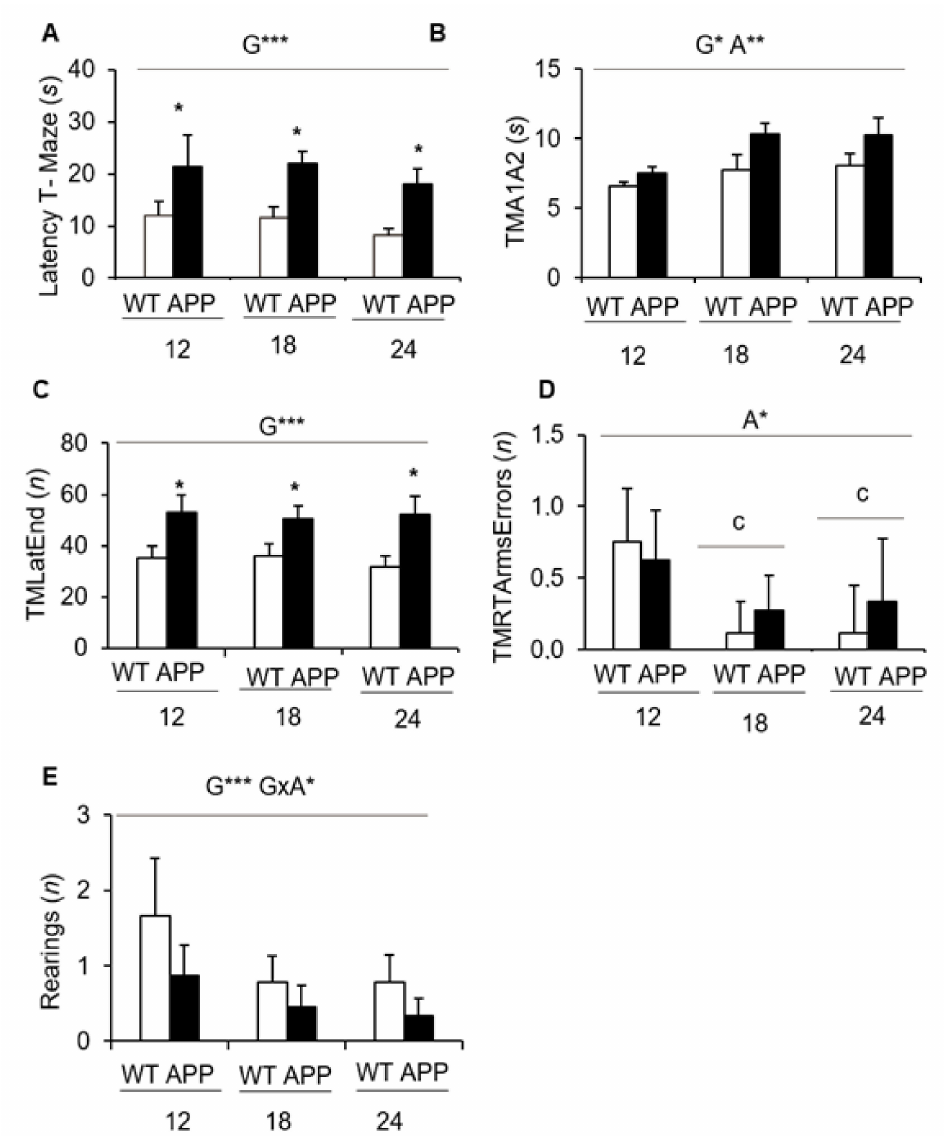
Figure 4. Coping with stress strategies, risk assessment, and spontaneous alternation in the T-Maze. ( A ) Latency to cross the intersection; ( B ) Total time invested in the exploration of the left and right arms; ( C ), Time to complete the exploration of the maze; ( D ), Total number of errors performed during the exploration of the maze; ( E ) Vertical exploratory activity. Data are expressed by means ± SEM. WT: wildtype mice; APP: APP23 mice. Analysis of variance 2 × 2: Effects of genotype (G), age (A), genotype × age (G × A), * p < 0.05, ** p < 0.01, *** p < 0.001. Post-hoc analysis: c p < 0.05 vs. 12 months of age; * p < 0.05 vs. the corresponding WT control